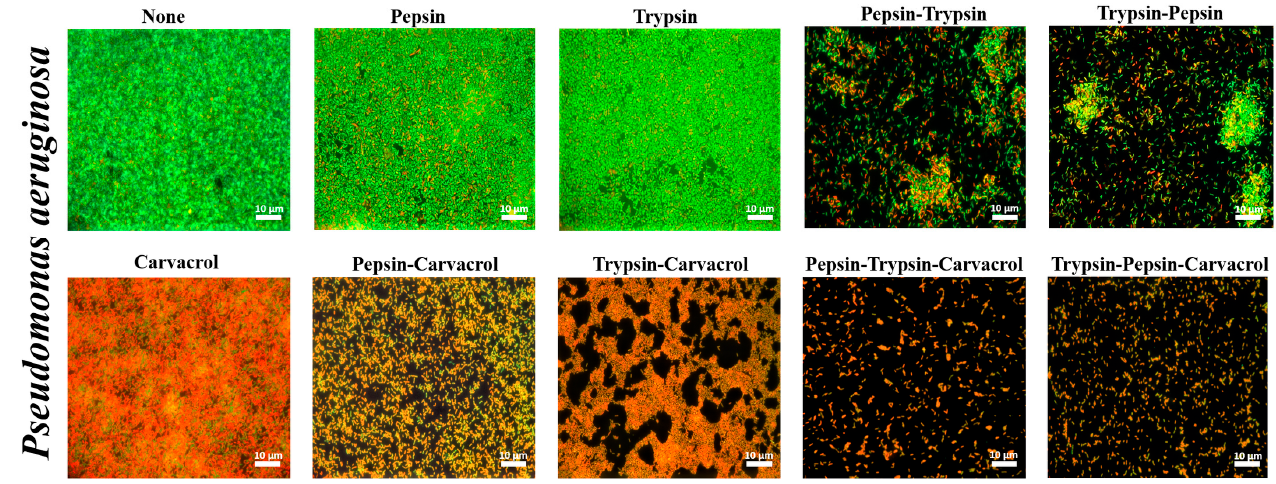
Figure 6. Epifluorescence microscopic images of P. aeruginosa biofilms after treatment with pepsin, trypsin, or sequential treatment of both at a concentration of 1 mg mL − 1 for 1 h each, or followed by treatment with carvacrol at ½ MIC (2.5 mg mL − 1 ) for 1 min. Cells were visualized after staining with SYTO9 (green fluorescence for living bacteria) and propidium iodide (red fluorescence for dead bacteria). Control represents biofilm treated with tryptone salt broth.